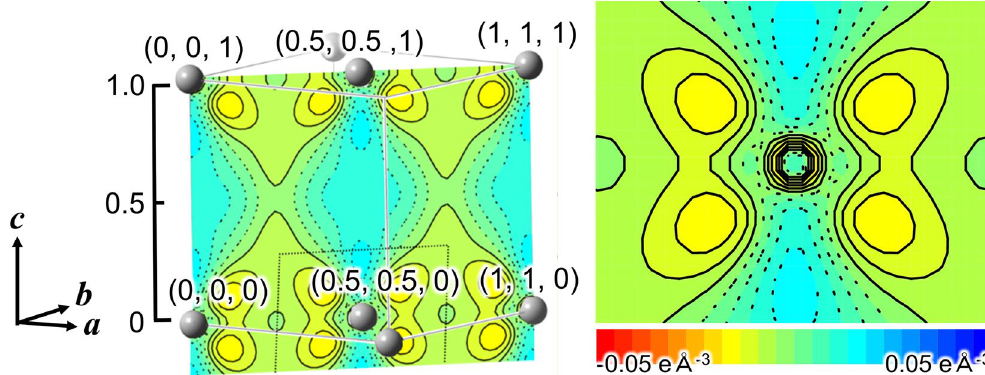
Figure 4. Charge-density difference between experiment and theory. The drawing plane is indicating in the left inset inside black dotted line. Aluminum atom is at the center of the plane. The contour interval is 0.005 eÅ − 3 in − 0.05–0.05 eÅ − 3 region. Solid and dotted lines show positive and negative contours,